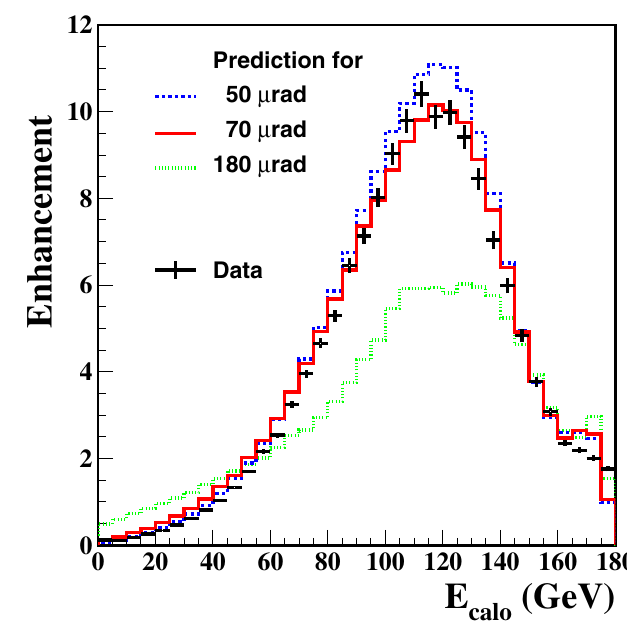
FIG. 14. (Color) Enhancement of CB radiation data compared to Monte Carlo predictions. Note the sensitivity of the cross section to small changes in the angular setting of the